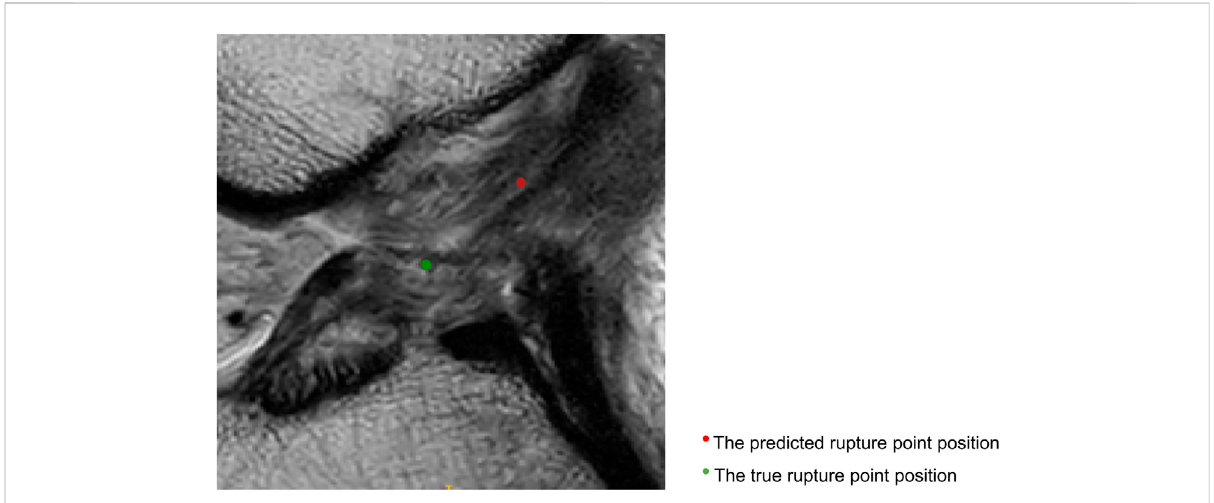
FIGURE 4 Sagittal views of the cropped MR image, mislocalization and false classi fi cation. The predicted rupture point is marked by red circle, while the true rupture point is green . The deep learning pipeline outputs incorrect localization results due to the Euclidean distance between the true and predictedrupturepointlocationsbeinggreaterthan10 mm,whichexceedsthemaximumerrorthresholdweset.Amislocalizationresultedinafalse classi fi cation. The true part of the rupture is the middle side, but the prediction is femoral